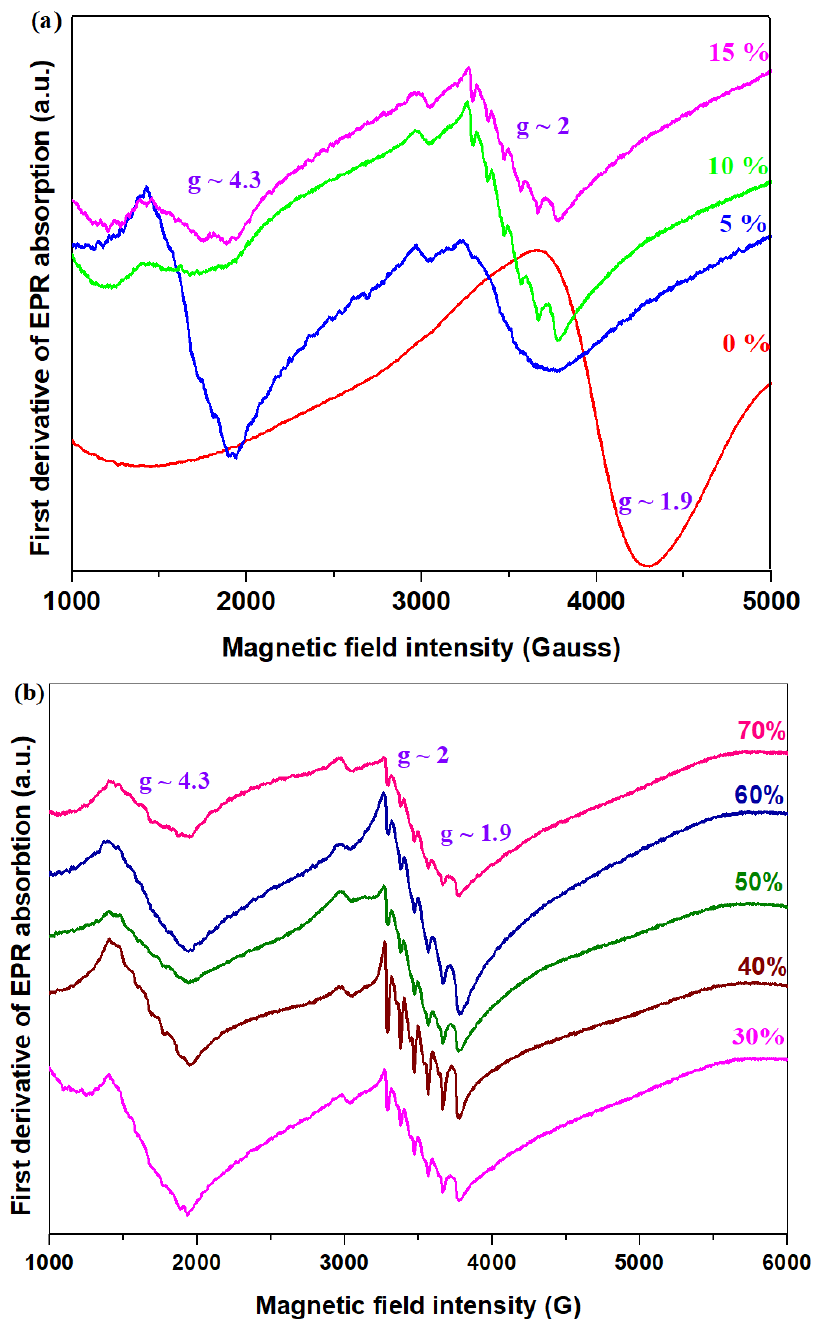
Figure 5. EPR spectra of samples prepared in the xNaH 2 PO 4 ·5MnO 2 ·(95 − x)[4PbO 2 ·Pb] composition where ( a ) x = 0 – 30 mol% NaH 2 PO 4 and( b ) x = 40 – 70 mol% NaH 2 PO 4 . The EPR spectrum of host matrix shows a broad resonance signal centered at about 3950 Gauss, which comes from the resonance line located at the gyromagnetic factor g~2 due to Mn +2 ions located in octahedral coordination [20] superimposed with the reso- nance line centered at g~1.9 corresponding to the Mn +4 ions. The highly symmetric tet- Through doping with NaH 2 PO 4 a new resonance line appears centered at g~4.3 and the signals located at g~1.9 and g~2 indicates a hyperfine structure, except for the sample with x = 5 mol% NaH 2 PO 4 . The resonance line located at g~4.3 corresponds to the strongly distorted octahedral sites of Mn +2 ions [22].The intensity of the signal centered at about g~4.3 reaches a maximum value for the sample with x = 5 mol% NaH 2 PO 4, after which its intensity decreases drastically for the sample with 20 mol% NaH 2 PO 4 . For higher NaH 2 PO 4 concentrations (x ≥ 40 mol%), all resonance lines indicate a well-resolved hyperfine structure.